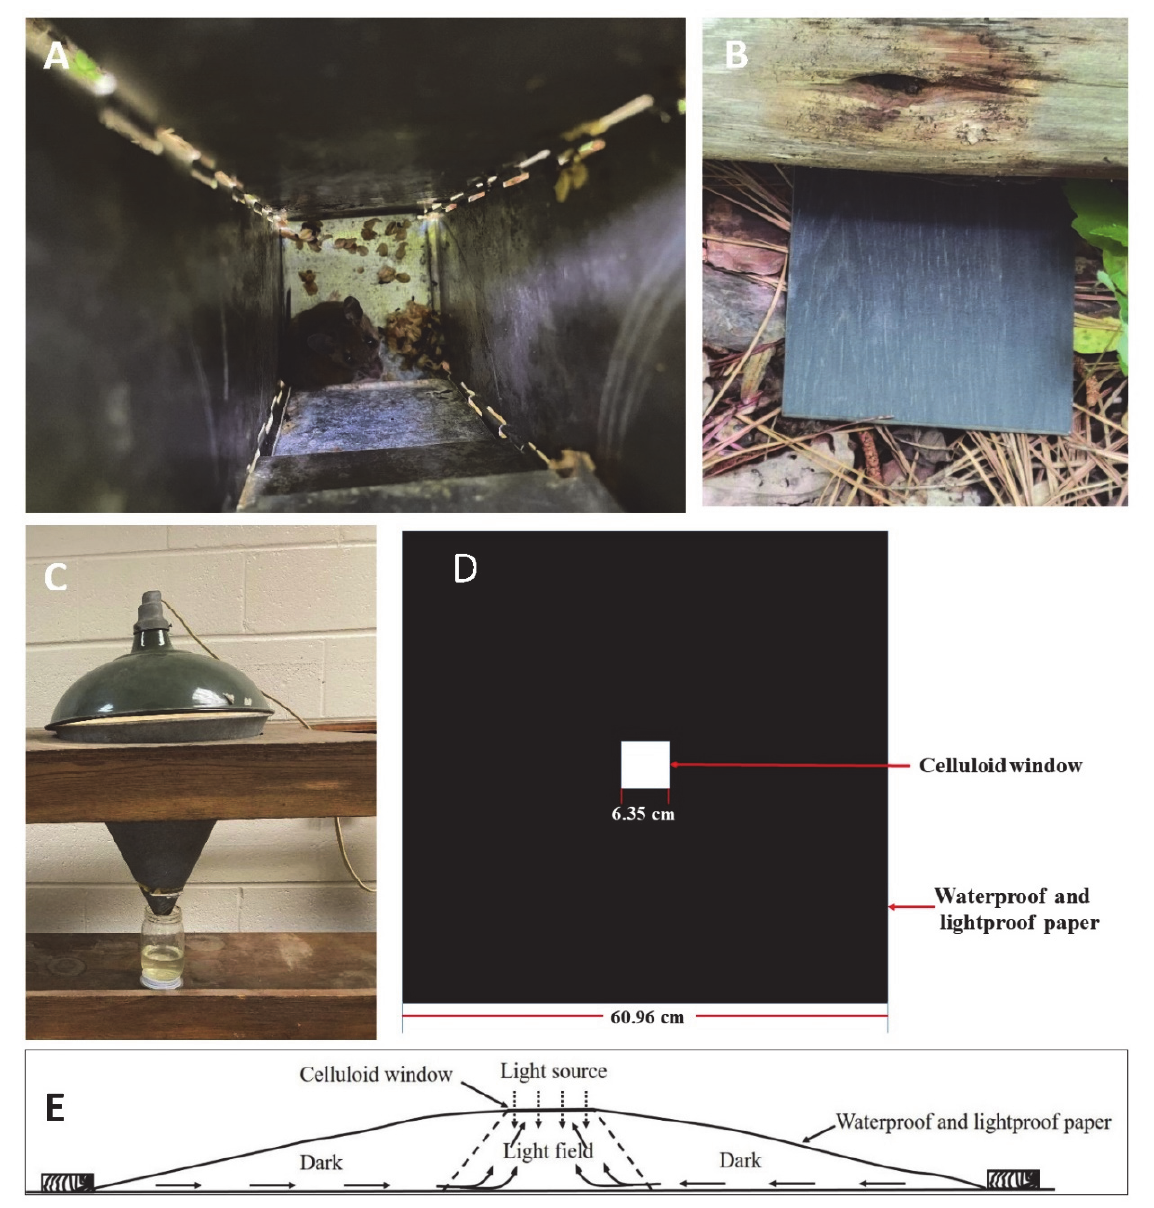
Figure 3. Chigger collecting methods: ( A ) live ‐ trapped rodents in Sherman traps (photo credit to Reuben Garshong); ( B ) black tile on the ground; ( C ) Berlese funnel (photo credit to Steve Denning); ( D ) light trap (modified from [29]); ( E ) horizontal view of light trap, arrows inside the trap show the paths taken by chiggers (modified from [29]).